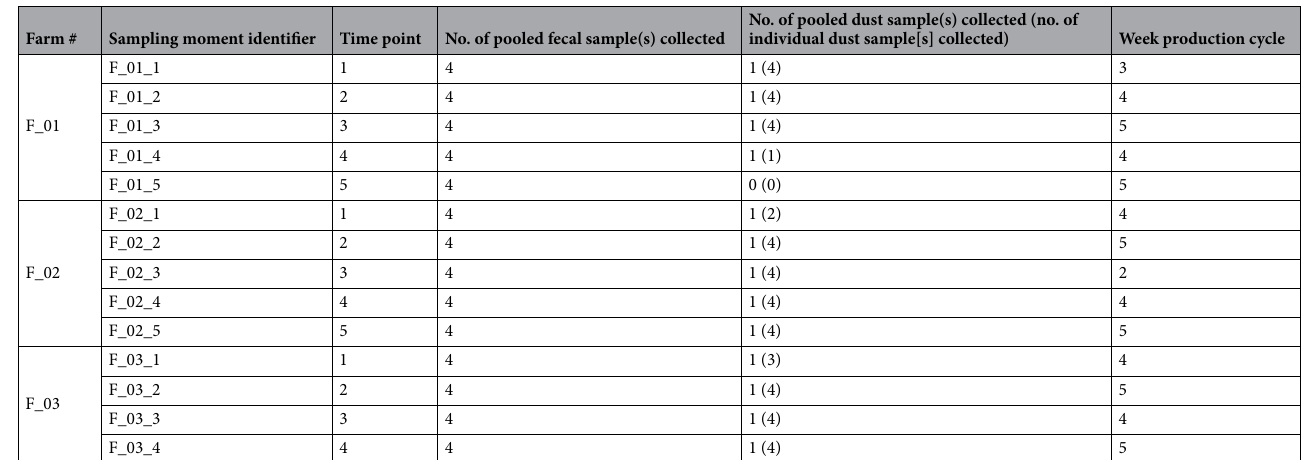
Table 3. Detailed sampling